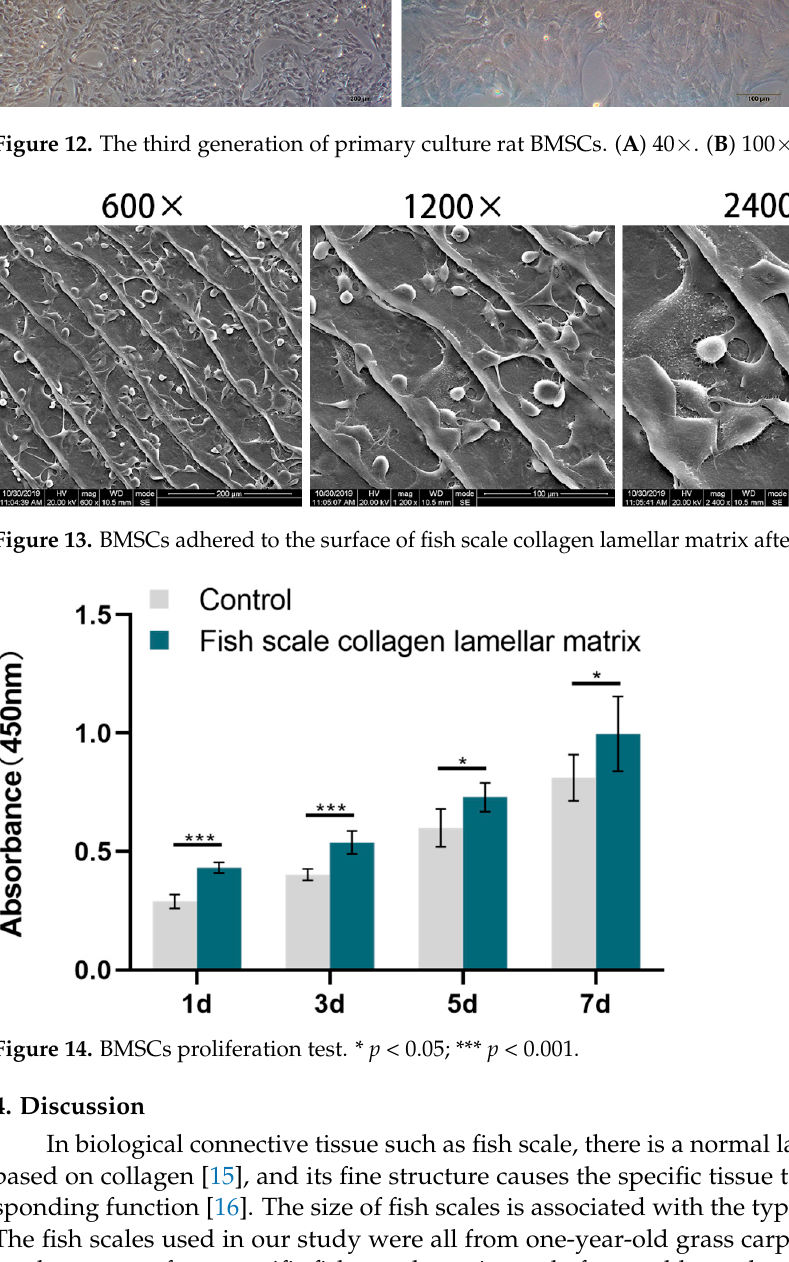
Figure 14. BMSCs proliferation test. * p < 0.05; *** p < 0.001.